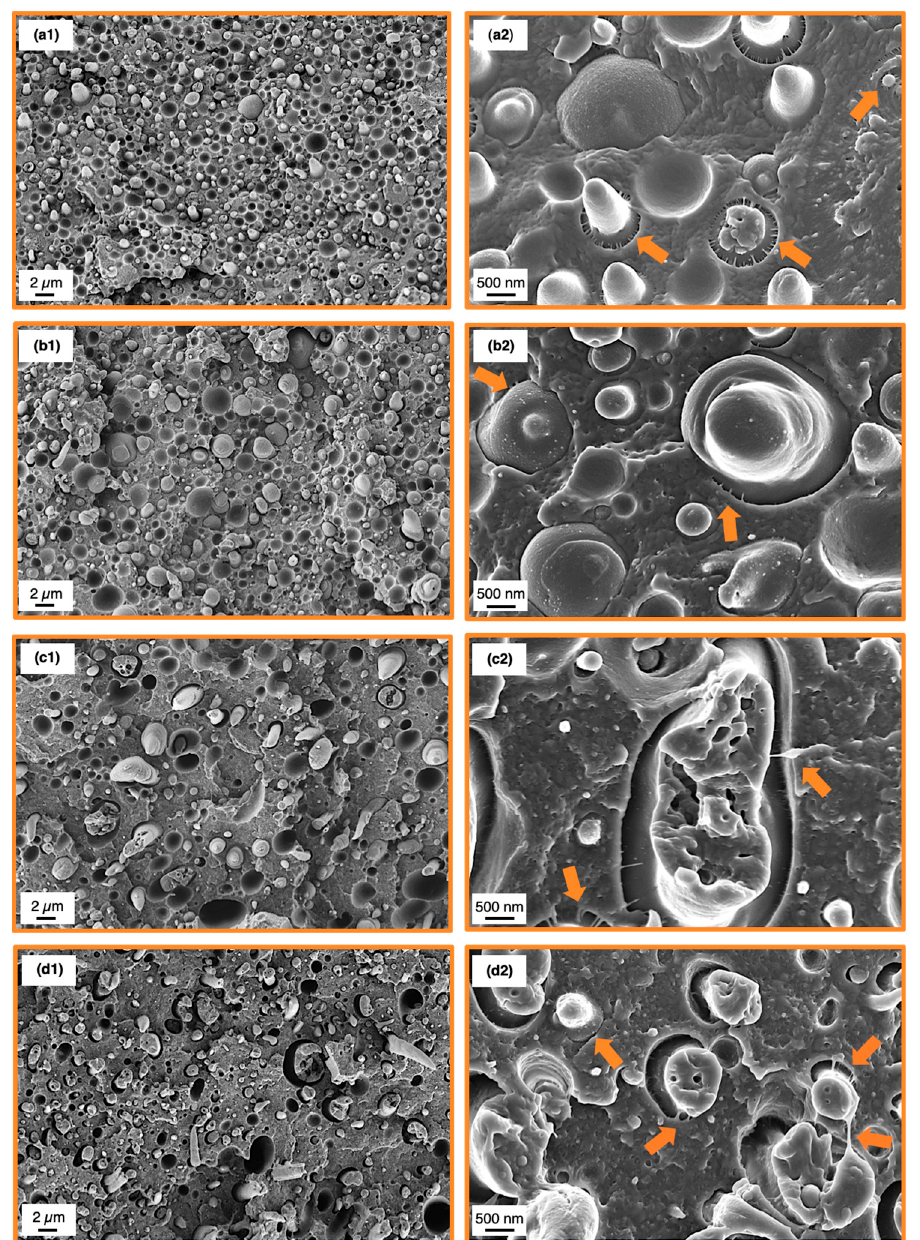
Figure 6. Scanning electron microscopy (SEM) micrographs subsequent to tensile testing of the 60/40 binary blend ( a1 ), 5 wt% SMA ( b1 ), 10 wt% SMA (c1) and 15 wt% SMA (d1). Higher magnifications of the corresponding blends are depicted at the right column ( a2 , b2 , c2 , d2 ). Orange arrows indicate matrix fibrillations.